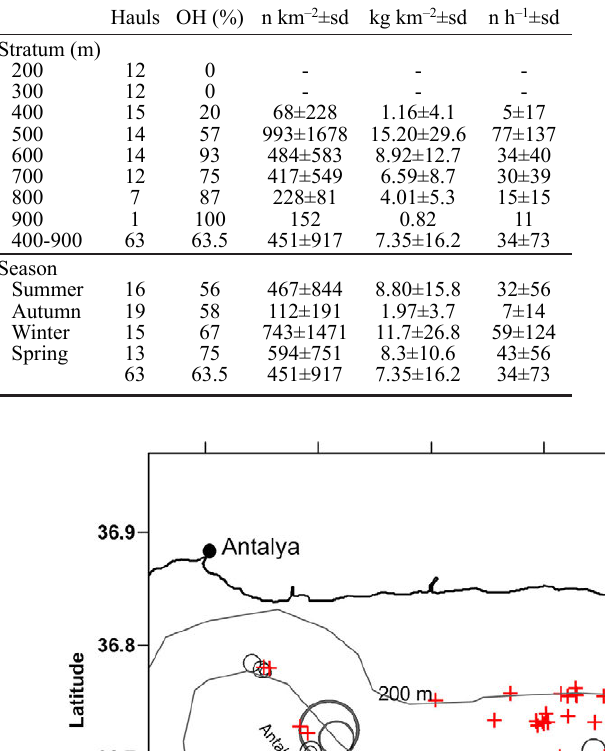
Table 2. – Mean abundance (n km –2 ), biomass (kg km –2 ) and catch per unit effort (n h –1 ) indices with standard deviation (sd) computed by strata and seasons for A. antennatus from the STRATUM survey. OH, occurrence in hauls.